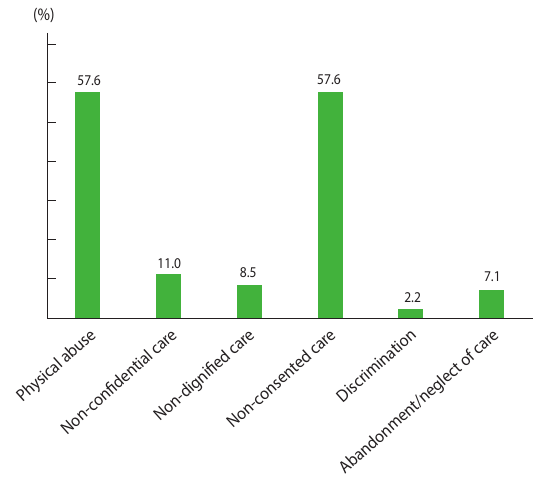
Figure 1. Frequency of disrespect and abuse by category during fa- cility based childbirth in Bahir Dar town, North West, Ethiopia, March 1 to 30, 2017 (n= 410). Values are presented as percentage each from 100%.